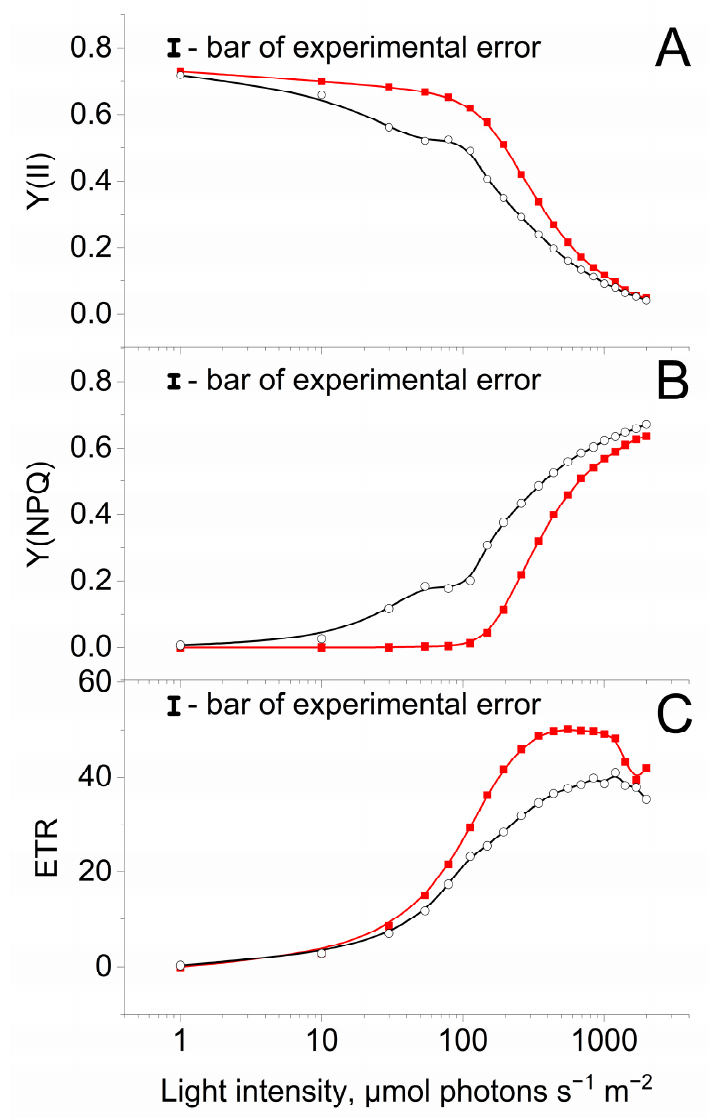
Figure 5. Dependence of Y(II) ( A ), Y(NPQ) ( B ) and ETR ( C ) on light intensity in plants growing under common (red, closed squares) and photoconversion (black, opened circles) films. Measurements were done at room temperature. The data are the means of at least three measurements, with the standard deviation of the